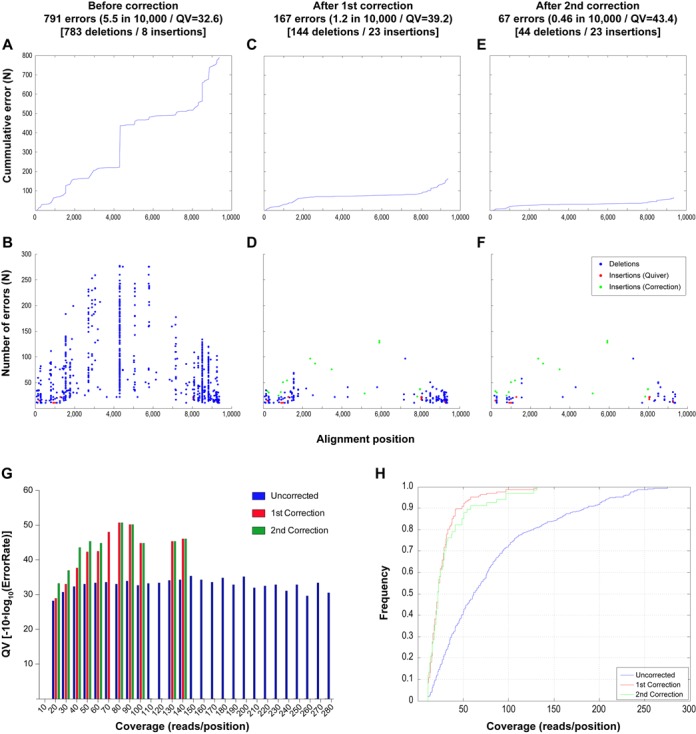
Analysis of errors found before and after implementation of INDEL correction algorithms. The cumulative and absolute number of errors across the alignment is shown for the sequences obtained before performing INDEL correction (A, B) and after performing the first (C, D) and second (E, F) INDEL correction. In addition, the QV according to depth of sequence coverage is shown (G) for the uncorrected alignment (blue) as well as for the alignment after the first (red) and second (green) correction. Panel h. shows the cumulative frequency of errors against coverage, showing that before implementation of the correction algorithm, the errors were frequent even at positions with high coverage, while after correction, 90% of the error was limited to positions with coverage less than 50×.